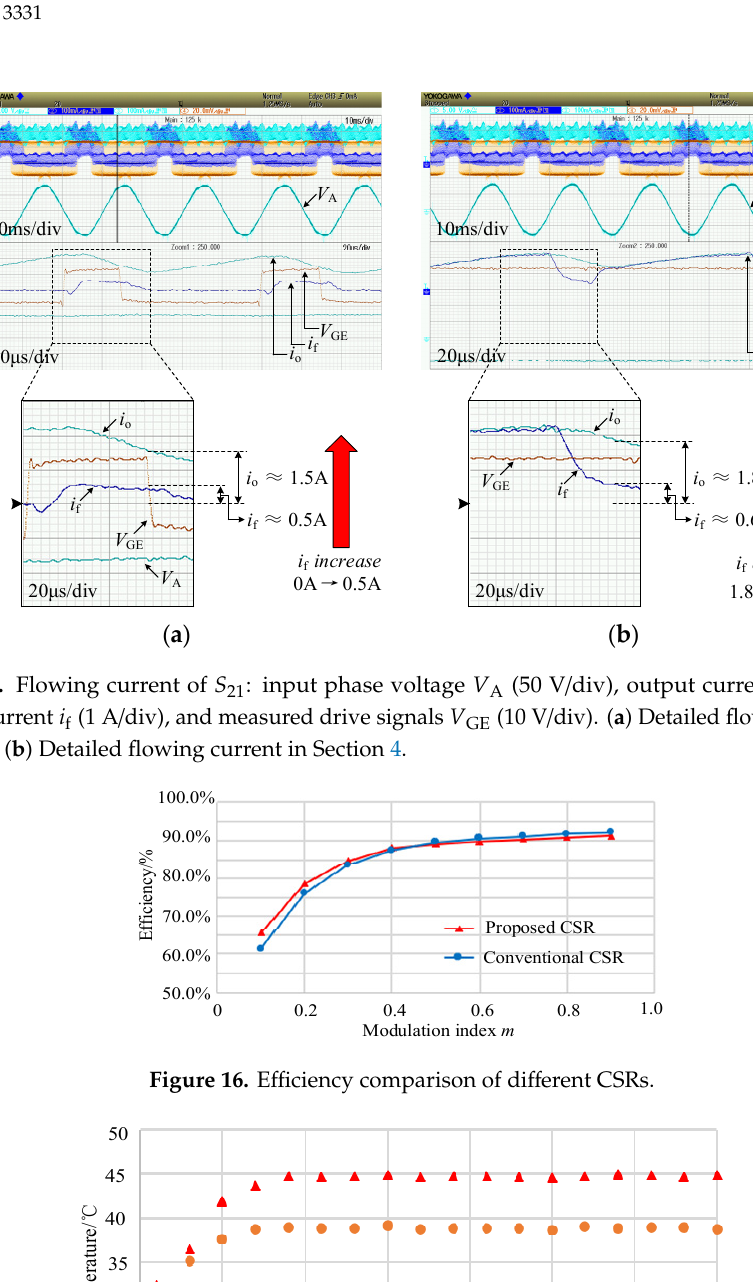
Figure 15. Flowing current of S 21 : input phase voltage V A (50 V/div), output current i o (1 A/div), flowing current i f (1 A/div), and measured drive signals V GE (10 V/div). ( a ) Detailed flowing current in Section 1. ( b ) Detailed flowing current in Section 4.